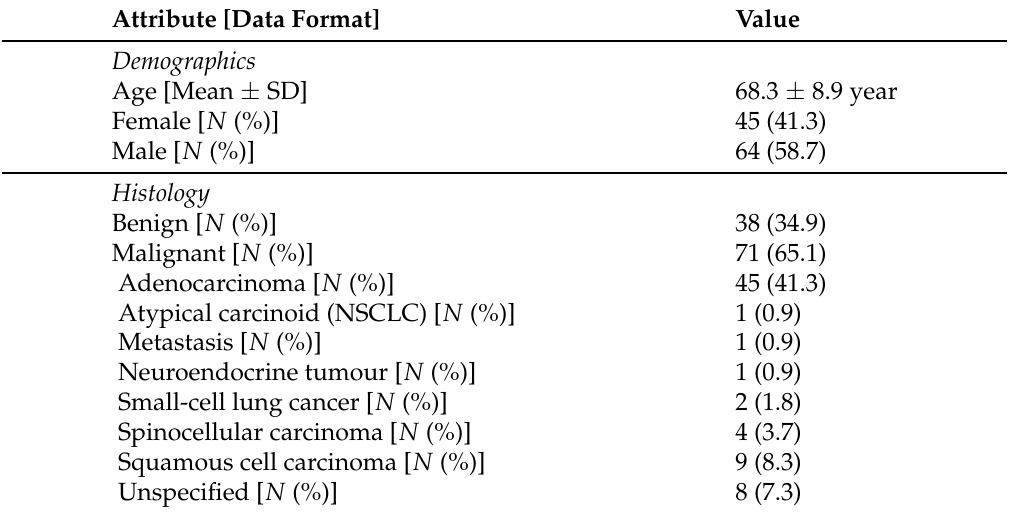
Table 1. Dataset SSR-1: Characteristics of the patient series.